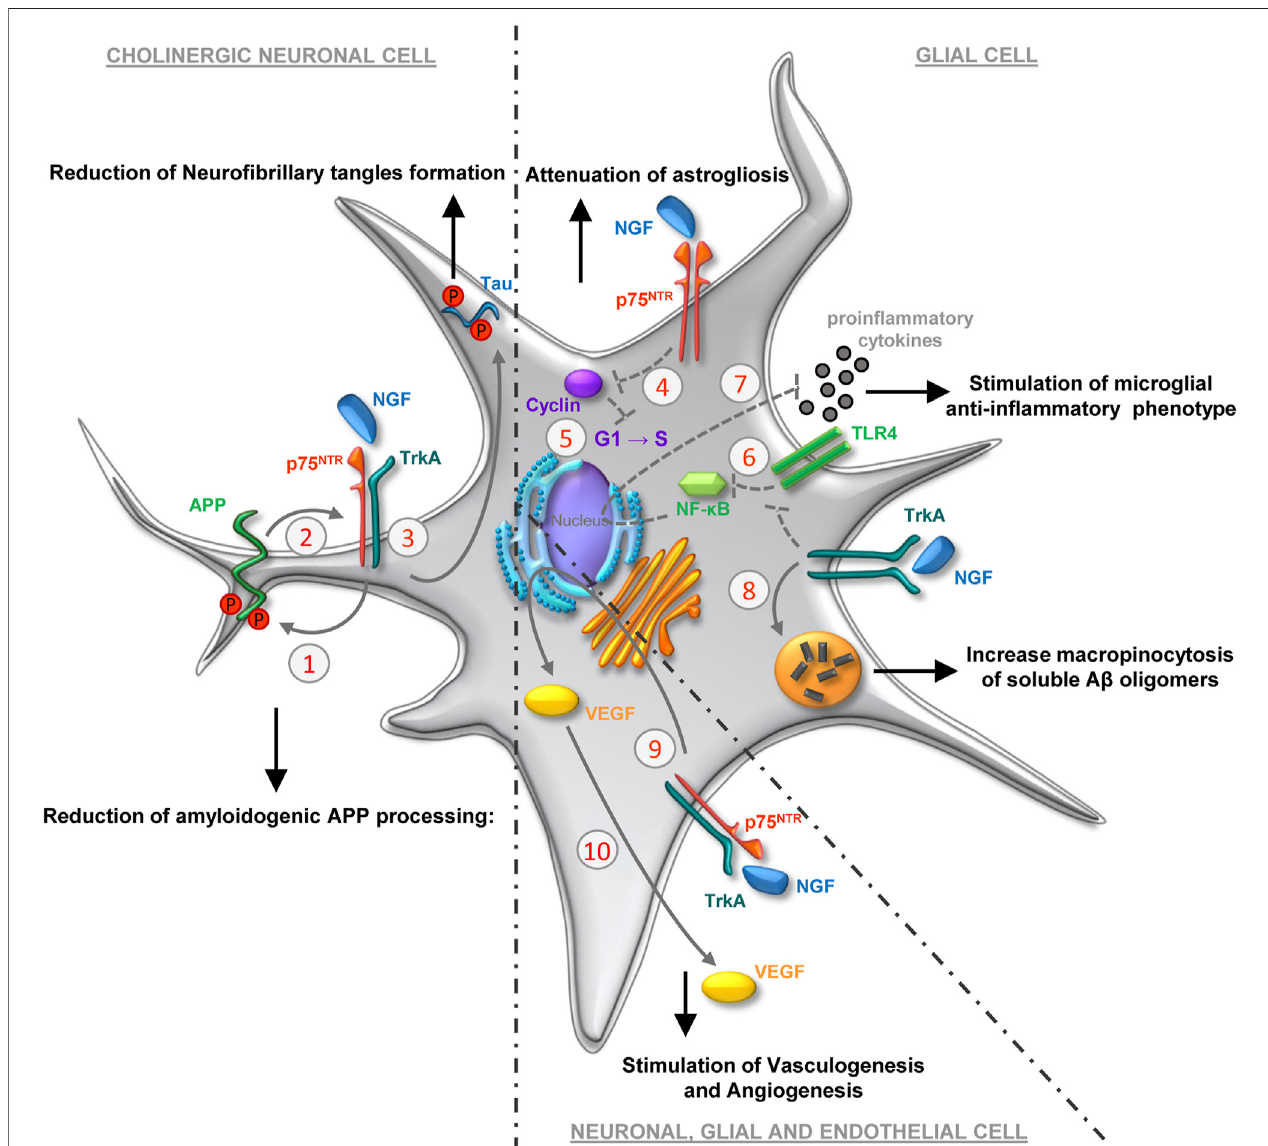
FIGURE 1 | Molecular and cellular mechanisms underlying the therapeutic effect of NGF in the central nervous system. Other than the canonical effects on the phenotypic maintenance of basal forebrain cholinergic neurons, several mechanisms have been proposed to explain the outcomes elicited by the conveyance of exogenous NGF to the brain. The phosphorylation of APP (1) is regulated by the rate of APP/NGF-receptor association (2), in turn modulated by the interaction of NGF withthehomodimerTrkA/TrkAand/orheterodimerTrkA/p75NTR(Canuetal.,2017b).TheAPP/NGF-receptorassociationmakesAPPlesspronetobeprocessed by β - and γ -secretases, resulting in decreased A β oligomerization in neurons expressing NGF receptors. The binding of NGF to its receptor complex reduces tau neuro fi brillarytanglesformation(3),regulatingthepost-translationalmodi fi cationoftau(phosphorylation,cleavage,andubiquitination)(Canuetal.,2017b).Inastrocytes, NGF/p75NTRinteraction attenuatestheinduction ofcyclins(4),therebypromoting thewithdrawalofastrocytes fromthecellcycle (5)attenuatingastrogliosis(Cragnolini et al., 2012). NGF, inhibiting early TLR4-mediated activation of the NF κ B (6) and JNK pathways, attenuates pro-in fl ammatory cytokines release in microglia (7) and may thereby contribute to regulation of microglia-mediated neuroin fl ammation (Fodelianaki et al., 2019). NGF-TrkA binding modulates microglia motility, macropinocytosis and degradation of A β deposition (8) (Rizzi et al., 2018). NGF initiates signaling (9) that supports the production and release of VEGF (10), in turn involved in both vasculogenesis and angiogenesis (Samii et al.,